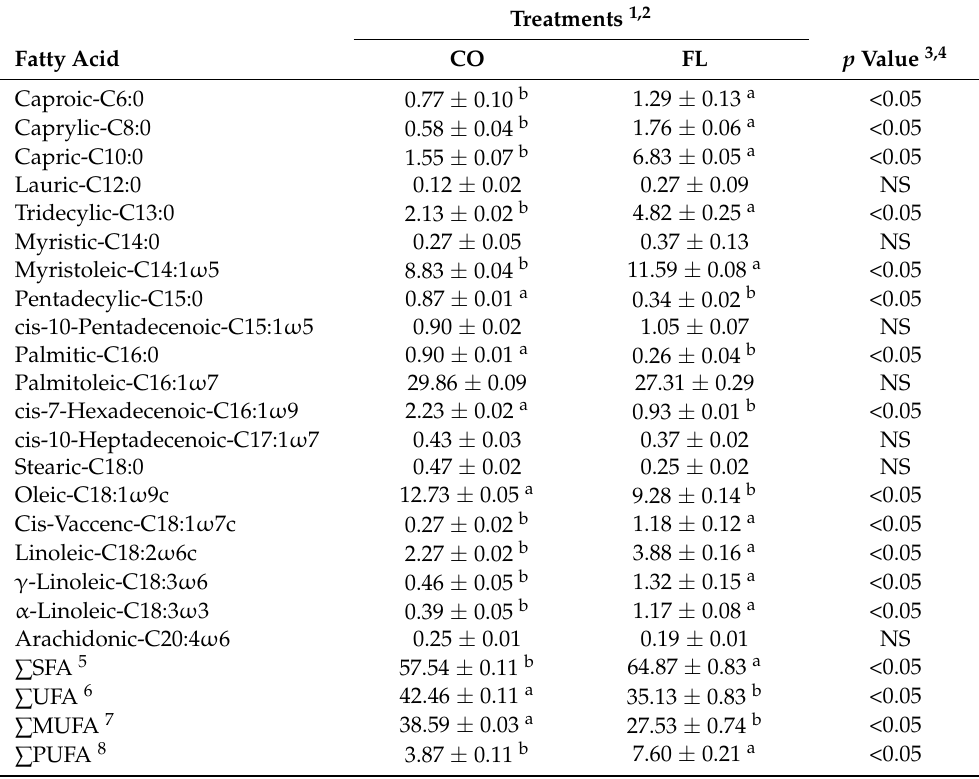
Table 5. Fatty acid composition (%) of white cheese from milk of cows subjected to different